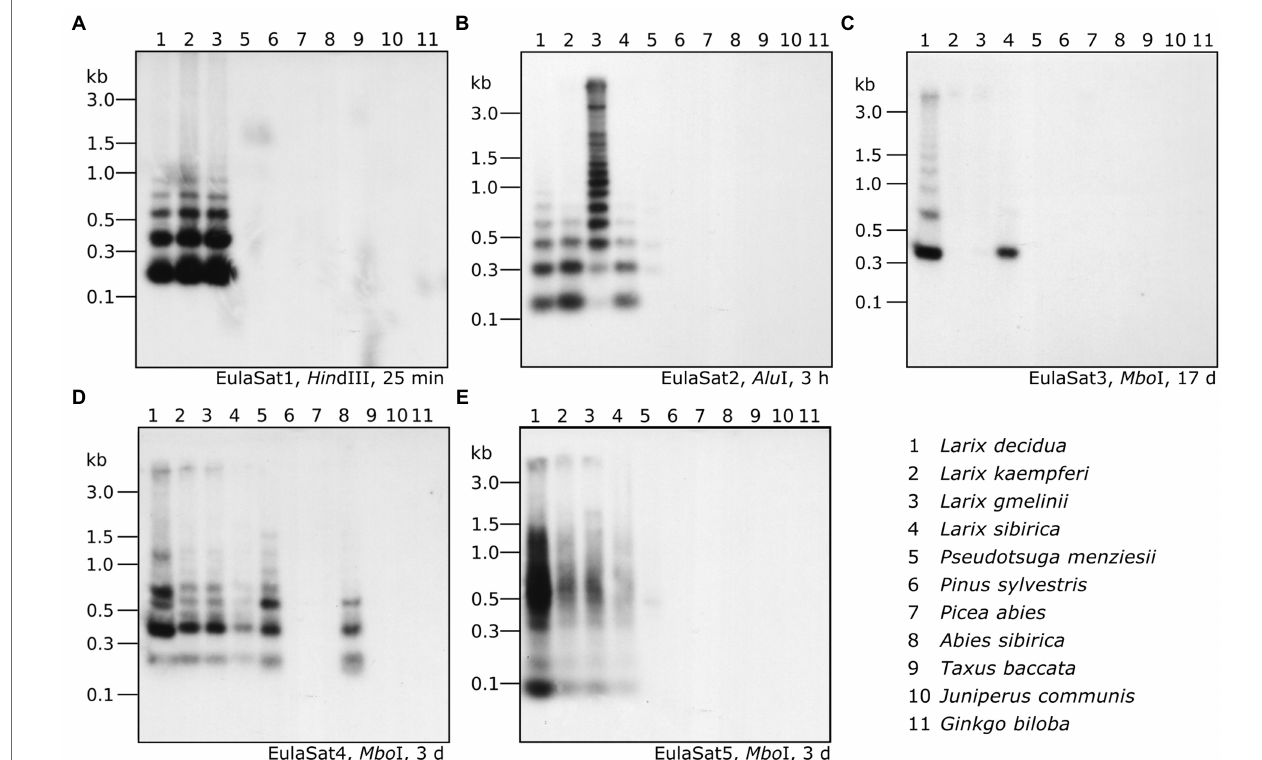
FIGURE 6 | Organization and abundance of EulaSat repeats in related gymnosperm genomes. Genomic DNA of eleven gymnosperms has been restricted as indicated in each panel and was analyzed by comparative Southern hybridization of EulaSat1 (A) , EulaSat2 (B) , EulaSat3 (C) , EulaSat4 (D) , and EulaSat5 (E) . Exposure times ranged between 25 min and seventeen days, as indicated below the